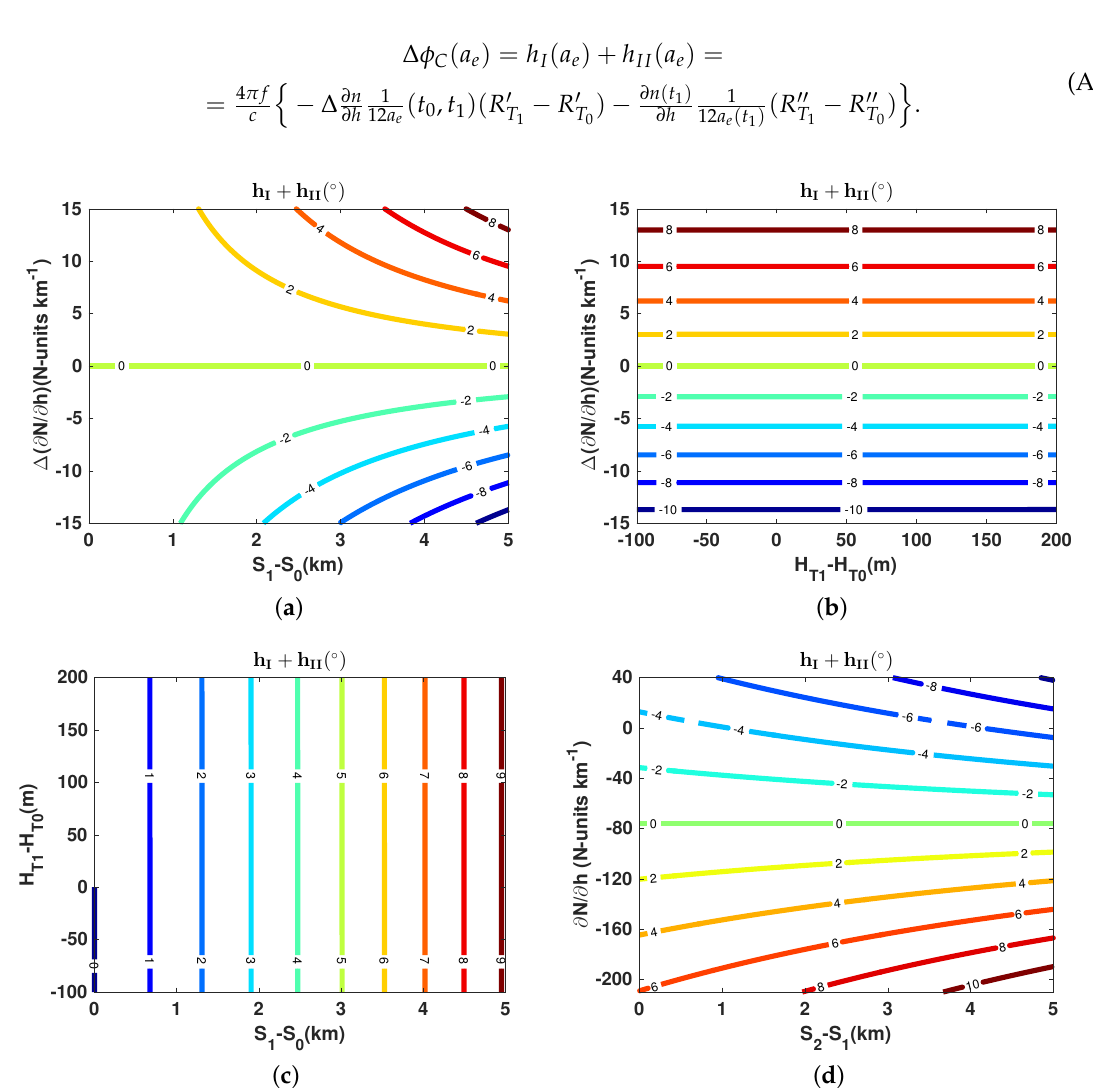
Figure A4. Contribution of the Earth’s curvature term to the total phase variation. ( a ) ∆ φ C ( ∆ [ ∂ n ( ∆ t ) / ∂ h ] , ∂ n ( t 1 ) / ∂ h ) as a function of the vertical gradient variation and arc distance between targets. The height difference between targets is set to 200 m; ( b ) ∆ φ C ( ∆ [ ∂ n ( ∆ t ) / ∂ h ] , ∂ n ( t 1 ) / ∂ h ) as a function of the vertical gradient variation and the height difference between targets. The arc distance from the radar to the first target and between targets are respectively set to 20 and 5 km; ( c ) ∆ φ C ( ∆ [ ∂ n ( ∆ t ) / ∂ h ] , ∂ n ( t 1 ) / ∂ h ) as a function of the arc distance and the height variations between targets. The vertical gradient variation is set to 15 N-units km − 1 ; ( d ) ∆ φ C ( ∆ [ ∂ n ( ∆ t ) / ∂ h ] , ∂ n ( t 1 ) / ∂ h ) as a function of the absolute vertical gradient and the arc distance between targets. The height difference between targets and the vertical gradient variation are set to 200 m and 15 N-units km − 1 ,